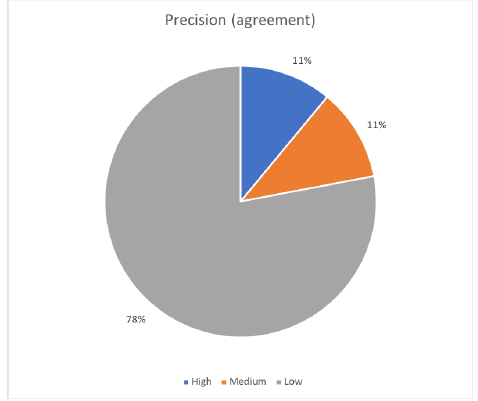
Figure 13. Crowdsourcing vs Expert geolocation - Agreement aggregation